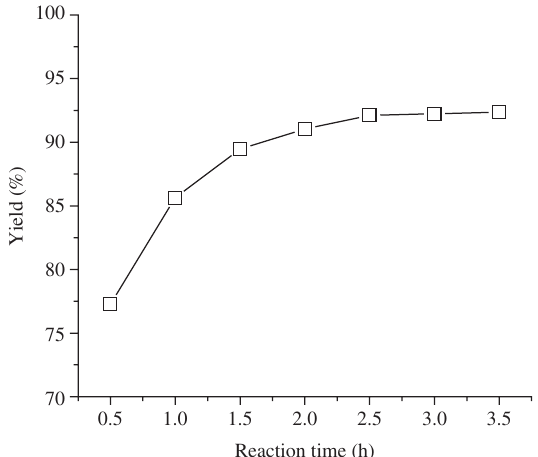
Figure 2 Yield of methyl caprylate by esterification of caprylic acid with methanol over (Tshx)(HSO